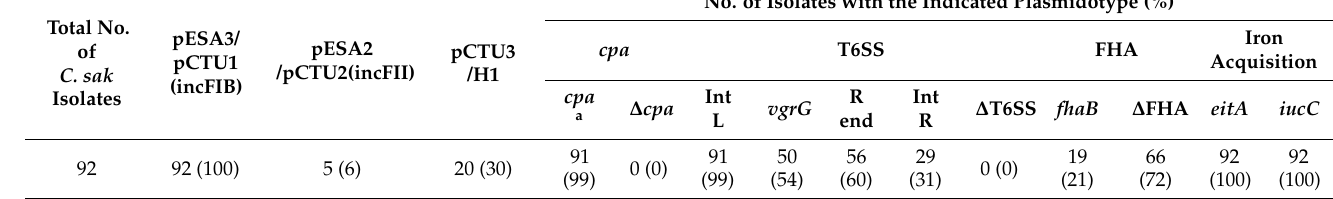
Table 4. Prevalence and distribution of pESA3-like incFIB, pESA2-like incFII, and pCTU3/H1- like plasmids and virulence factors harbored on pESA3-like plasmids among the plant-associated C. sakazakii